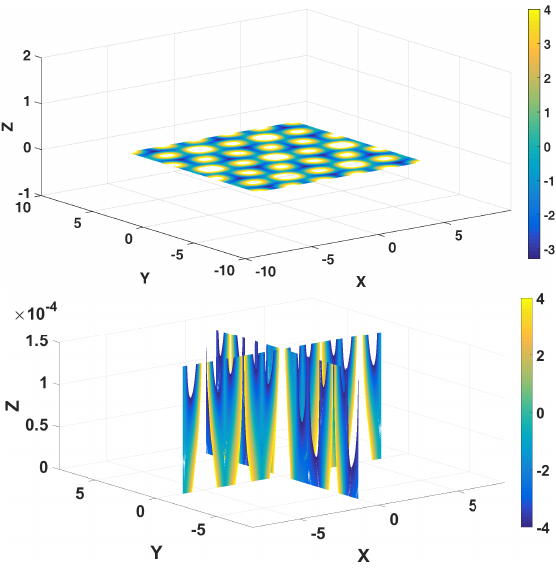
Figure 6. Plot of the concentration as a function of the deviation from onset of convection, namely c = c 0 + (cid:101) 2 c 2 , where (cid:101) denotes the amplitude of motion and c i are the O ( i ) contributions to the concentration. In this case, c 0 = H and c 2 is given by Equation (29). The plots depict c ( x , y , z ) as slices by planes x = 0, y = 0, and z = 0.05. We note that the xz slice reduces to the two-dimensional case studies in VH as shown in Figure 5. The z -slice covers a wider region in the xy -plane. The parameters used are as follows: Γ = 4, δ = 0.2, R = 1200, (cid:96) = 2, z 0 = 0.5, and (cid:101) = 0.5.